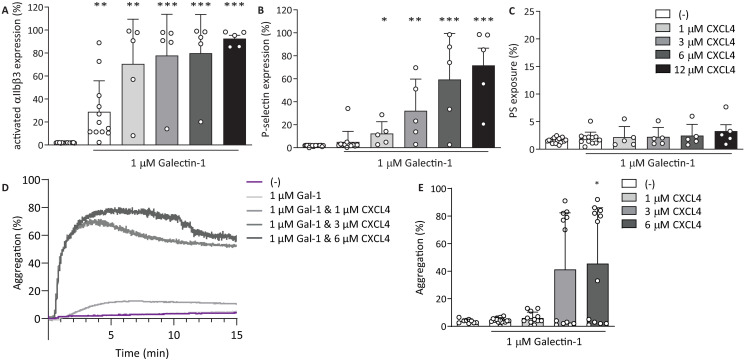
Co-incubation of galectin-1 and CXCL4 causes more P-selectin expression and faster aggregation.Gal-1 and CXCL4 were co-incubated on ice for 60 minutes prior to addition to platelets. (A,B,C) Flow cytometry analysis of platelets activated with 1 μM gal-1 alone or co-incubated with 1, 3, 6, or 12 μM CXCL4. Integrin αIIbβ3 activation (A), P-selectin expression (B) and PS exposure (C) were assessed using fluorescently labelled PAC-1, anti-CD62-P or Annexin A5, respectively. Light transmission aggregometry of washed platelets (D) and quantification (E) incubated with gal-1 and CXCL4. Bars represent mean ± SD (n ≥ 3), *p < 0.05, **p < 0.01, as compared to 1 μM gal-1 (Kruskal Wallis/Dunn’s test).